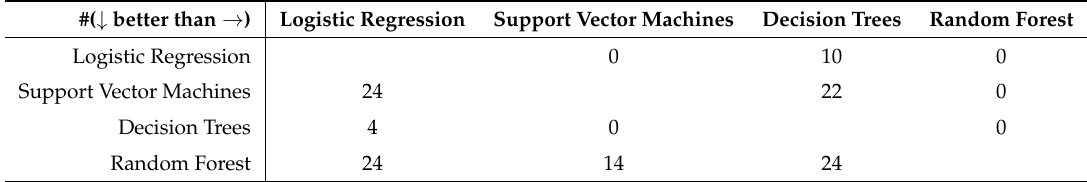
Table 3. Pairwise area under the ROC curve (AUC) comparison test